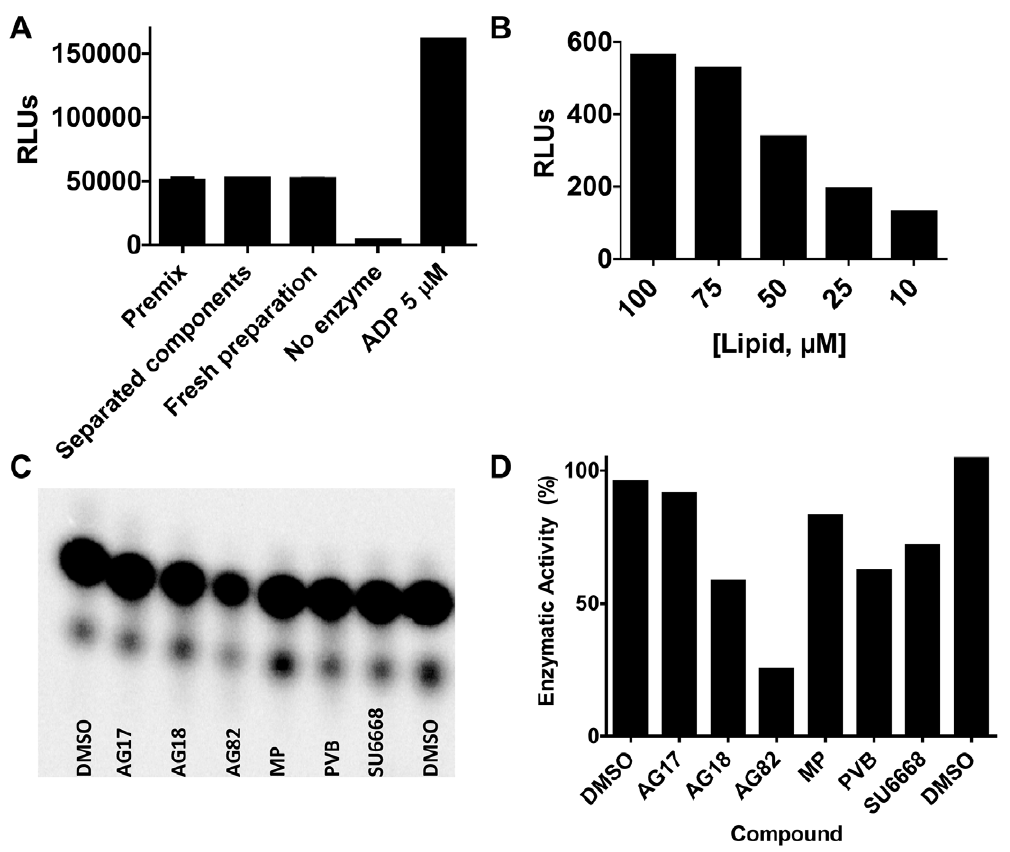
Figure 3. Lipid dependence, overnight stability and control compound. (A) The overnight (16 hour) stability of the assay reagents at 4 u C when the enzyme and lipid were premixed, stored separately or made up fresh as compared to a no enzyme and 5 m M ADP (representing 0% and 100% conversion, respectively). The error bars represent the standard deviation (N=2). (B) The PI5P lipid dependence of the PI5P4K a enzyme reaction. The error bars represent the standard deviation (N=2) and are not discernable on the plot. (C) and (D) Tyrphostin AG-82 (AG82) was identified as a weak inhibitor of PI5P4K a (decreases the enzyme activity by 75%) by a radiometric assay that uses c - 32 P-ATP and PI5P and measures the radiolabeled enzymatic product, PI(4,5)P 2 after the separation by thin layer chromatography. Five additional compounds were tested and found not to significantly inhibit PI5P4K a (AG17= tyrphostin AG-17, AG18= tyrphostin AG-18, MP=mycophenolate, PVB=purvalanol B and SU6668). All compounds were tested at 100 m M, except for PVB, which was tested at 10 m M due to solubility limitations at higher concentrations. The raw image and the extracted data are shown in (C) and (D), respectively. The commercial PI5P substrate predominantly contains two palmitate groups with a very small amount of deacylated lipid lyso-PI5P that contains only one palmitate group. The intense top spots in (C) represent the PI(4,5)P 2 product with two palmitate groups, and the faint spots below represent the product with just one palmitate group. Table 1. The signal to background of the PI5P4K a assay was quite comparable when the substrate was prepared by the method of Demian et al . and the method described here (S/B = 12 -13, Figure S1) [17], indicating that the new lipid preparation could function as a substrate for PI5P4K a . Additionally, the lipid mixture was found to be stable to at least six rounds of freeze/thaw (data not shown), which allows the substrate to be prepared and validated in large batches and used for multiple experiments.